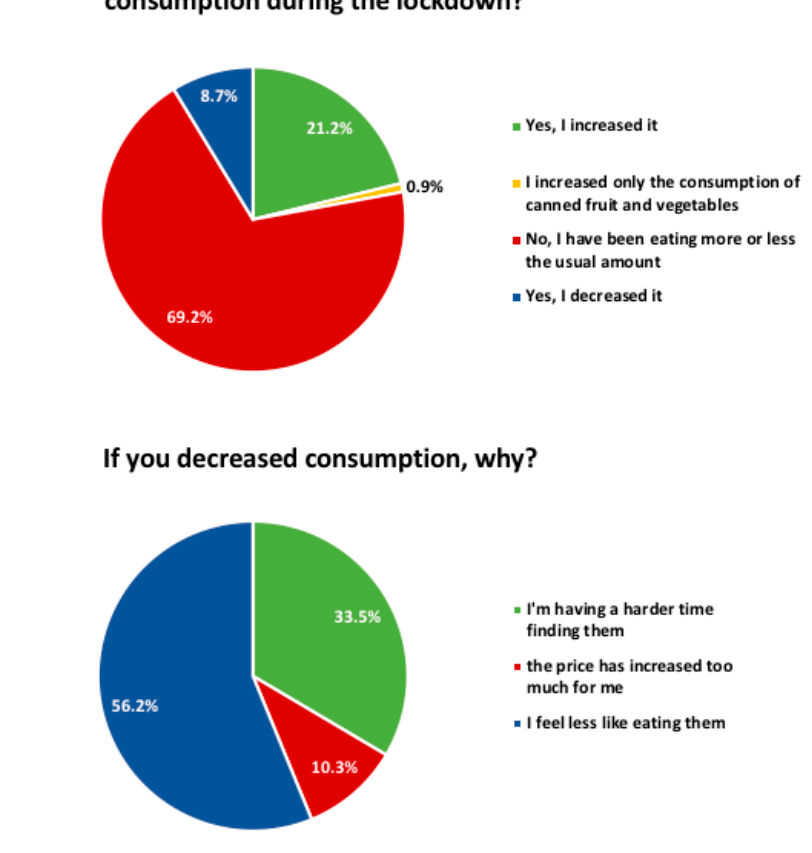
Figure 3. Reported produce consumption during the lockdown.